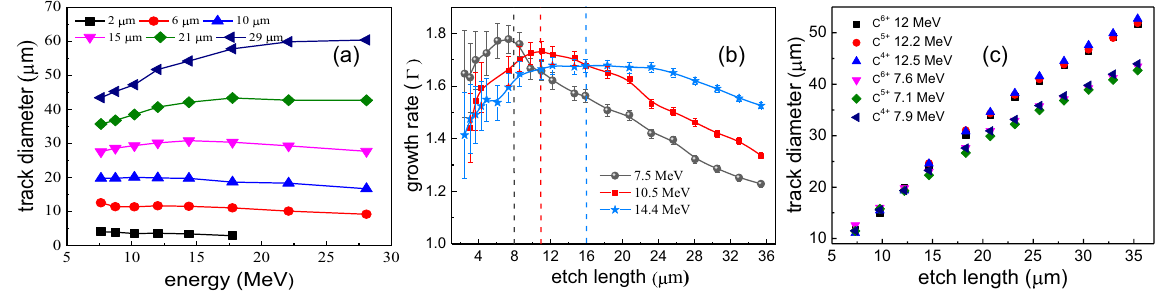
Figure 3. Evolution of the Carbon ion tracks. ( a ) The track diameter variation of C 6 + for selected bulk etch length as a function of its energy. ( b ) The track diameter growth rate for 7.5 MeV, 10.2 MeV and 14.4 MeV C 6 + energies as a function of bulk etch length. The vertical dashed lines indicate position of Bragg peak for different Carbon ion energy. ( c ) The track diameter variation of C 4 + , C 5 + and C 6 + for two different energies as a function of bulk etch length.